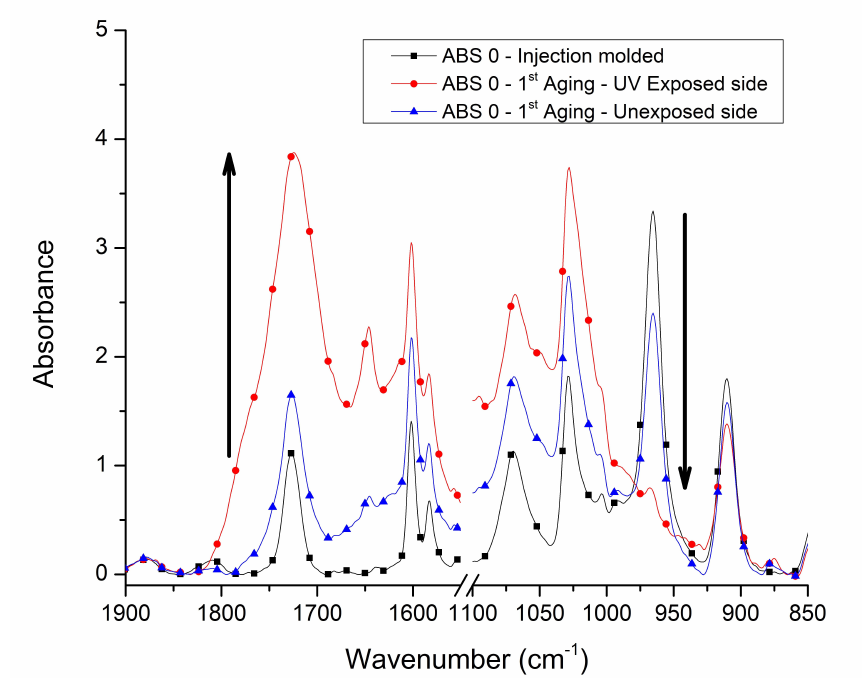
Figure 2. FTIR spectra of the sample ABS 0 (no extra stabilizer system; entry 1 in Table 1): injection molded (unaged) and after the 1st aging step (surfaces exposed and unexposed to UV). For other samples, see Supplementary Materials—Figures